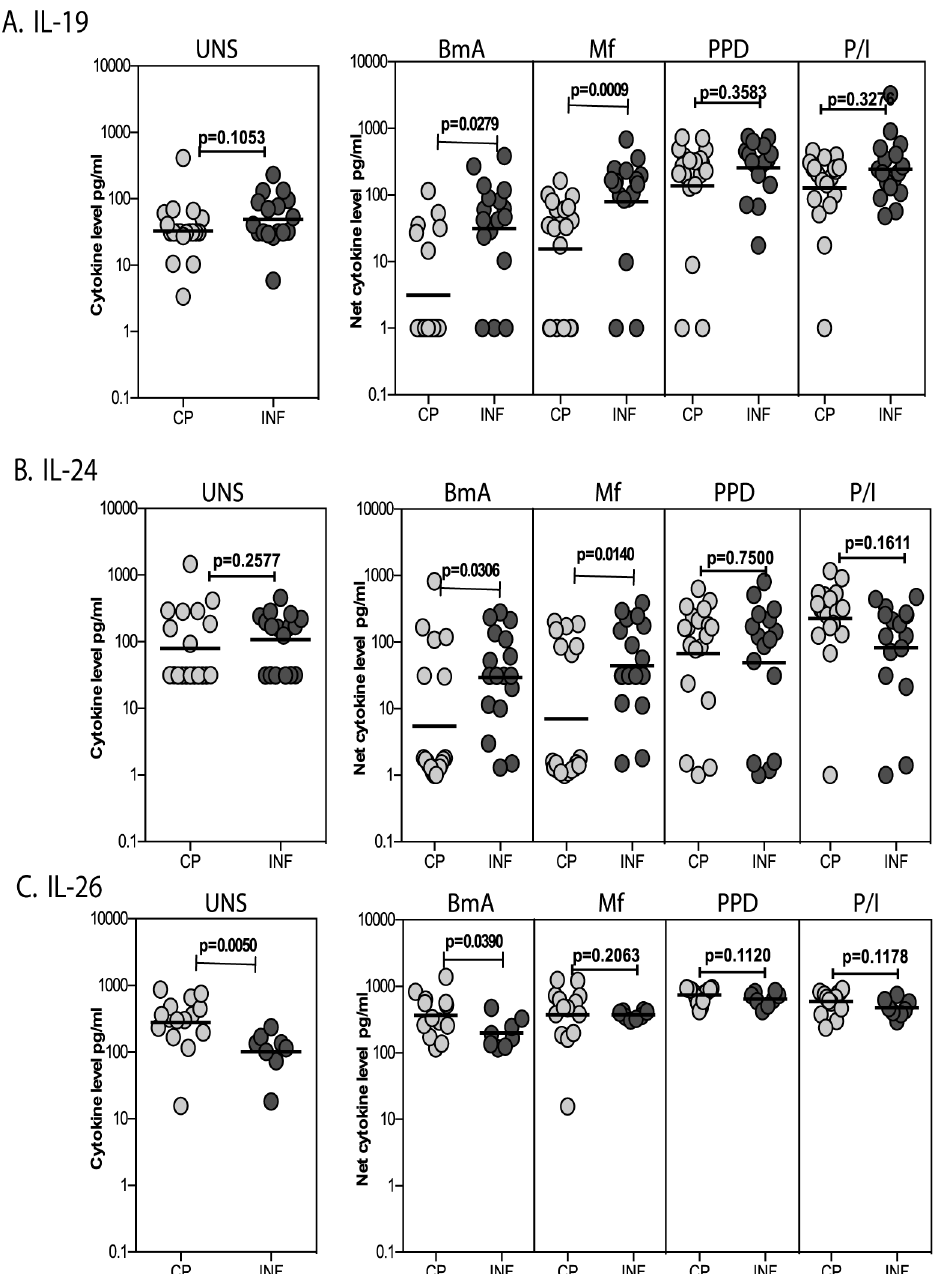
Figure 3. Filarial infection is associated with increased levels of antigen - induced IL-19 and IL-24 and decreased levels of IL-26. The total levels of IL-19 (A), IL-24 (B) and IL-26 (C) in PBMC culture supernatants at baseline or following stimulation with BmA, Mf, PPD or PMA/ionomycin in CP (n=19) and INF (n=17) individuals. Antigen – stimulated cytokine levels are shown as net cytokine levels with baseline subtracted. The data are shown as scatter plots with each circle representing a single individual or as bar graphs with geometric means and 95% confidence intervals. P values were calculated using the Mann-Whitney test.